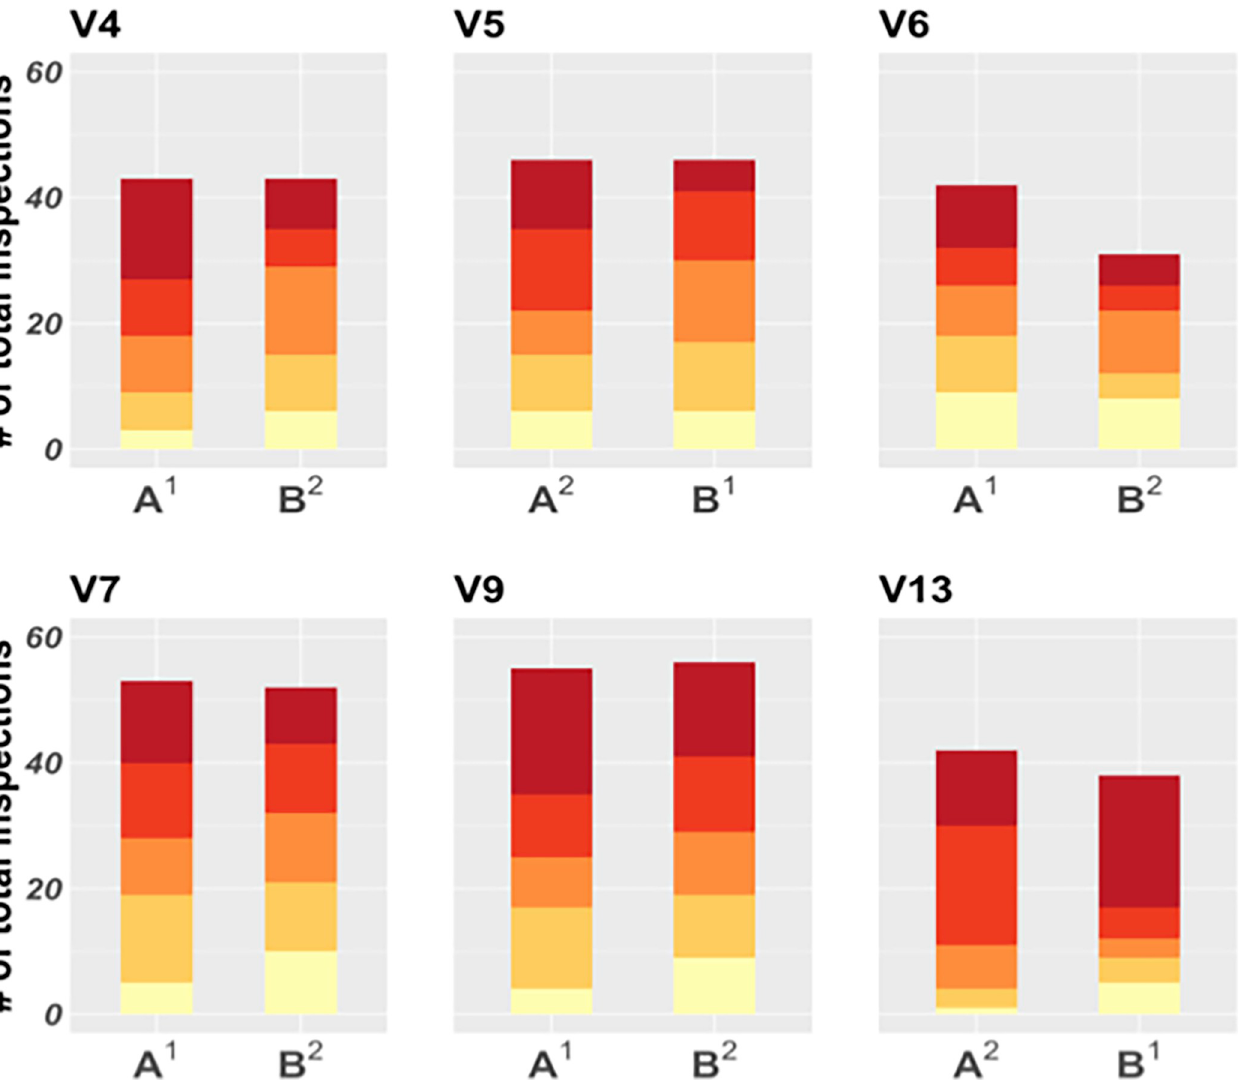
Fig 6. Infestation risk quintile distribution of households inspected by participants in the Cayma trial. Each set of two bars represents one participant, and each bar a study arm (A or B). A fixed incentive was used in arm A while the incentive in arm B was stochastic. Colors are ordered by risk quintile, going from the lowest (light yellow, bottom) to the highest (dark red, top). Arm A, (fixed incentive) had significantly higher risk information use than Arm B (stochastic incentive; POLR model, p < 0.02). Superscripts 1 and 2 in the x axis text indicate arm